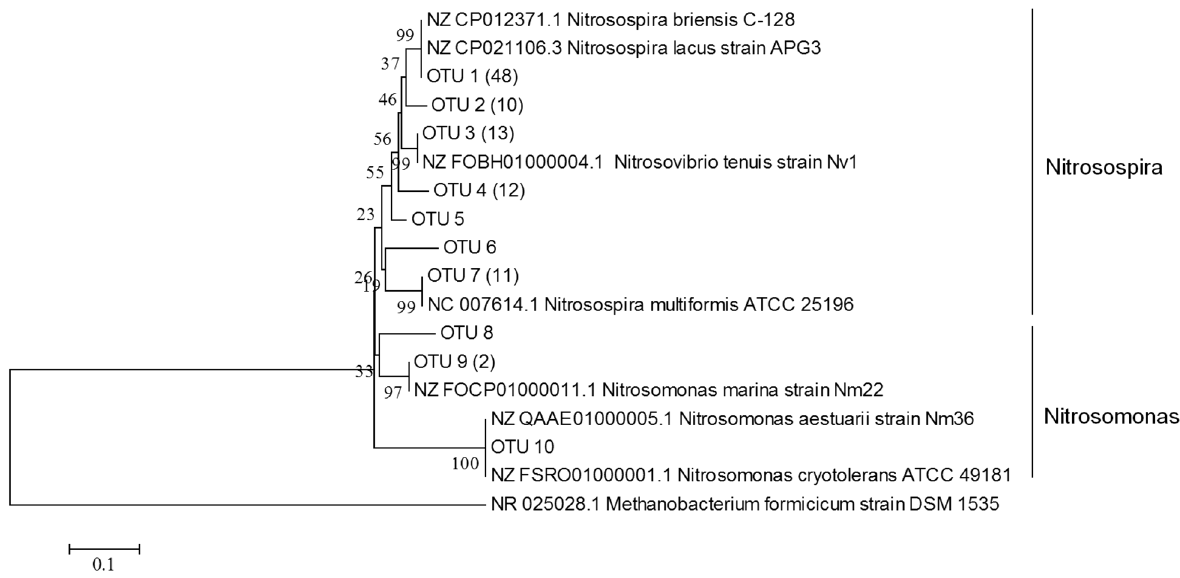
Figure 6. Neighbour-joining phylogenetic tree based on ammonia oxidizing bacterial amoA amino acid sequences. Clones with > 97% sequence similarity were considered as the same OUT and were named with OTU and numbers. Additional amoA sequences were obtained from the GenBank database. The scale bar represents 1% sequence